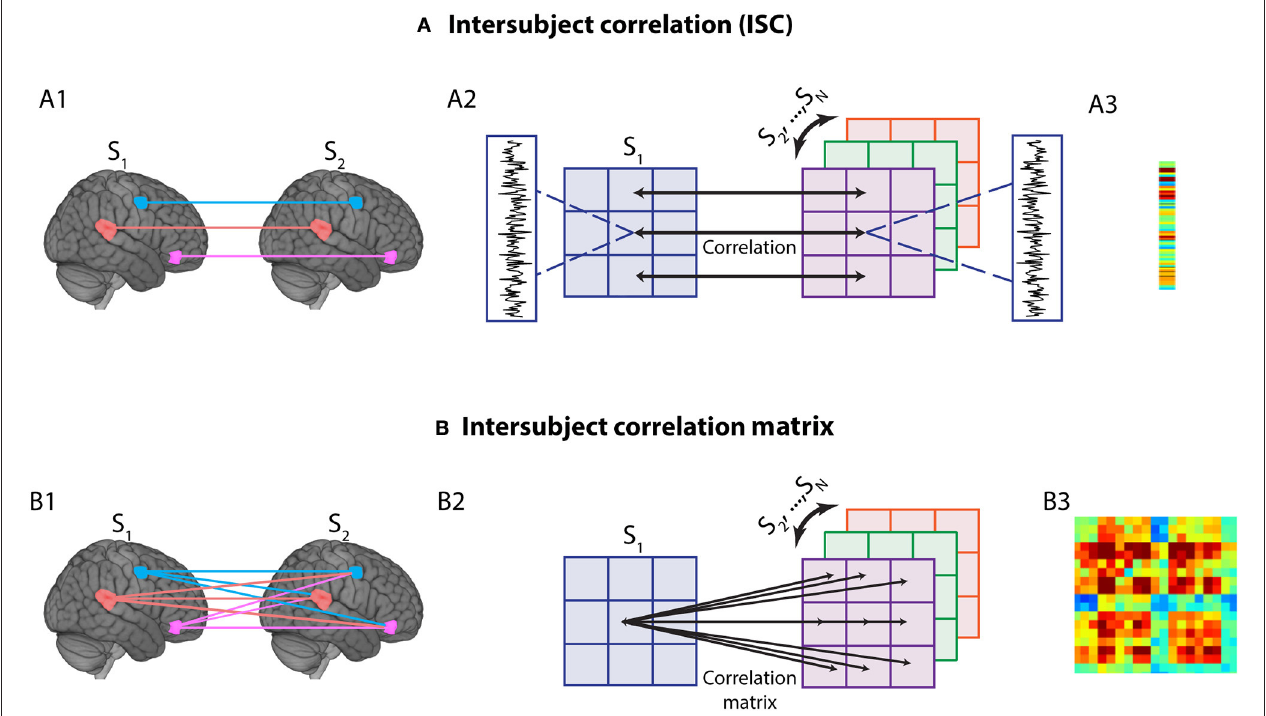
FIGURE 2 | Intersubject time series analysis. (A1) In standard intersubject analysis, correlation between the same region across different participants’ brains is calculated. (A2) To calculate intersubject correlation, for each voxel or region of interest (ROI), the time series for one subject (say, S1) is correlated with the average time series of all other subjects (S2,… SN), for the same voxel/ROI. This process is then iterated and averaged to determine group-level correlations, namely a vector that contains the correlation of every voxel/ROI with itself (across participants) (A3) . (B1) The method can be generalized to study multiple regions by computing the correlations between all pairs of voxels/ROIs across different brains. (B2) For each voxel/ROI, the time series of a one subject (say, S1) is correlated with the average time series across other subjects (S2,…,SN). This process is then iterated and averaged to determine group-level correlations, namely a matrix that contains the correlation of every voxel/ROI with every other voxel/ROI (across participants) (B3) . Note that the vector in A3 corresponds to the diagonal of the matrix in B3 , illustrating that intersubject networks provide a more general characterization of time series